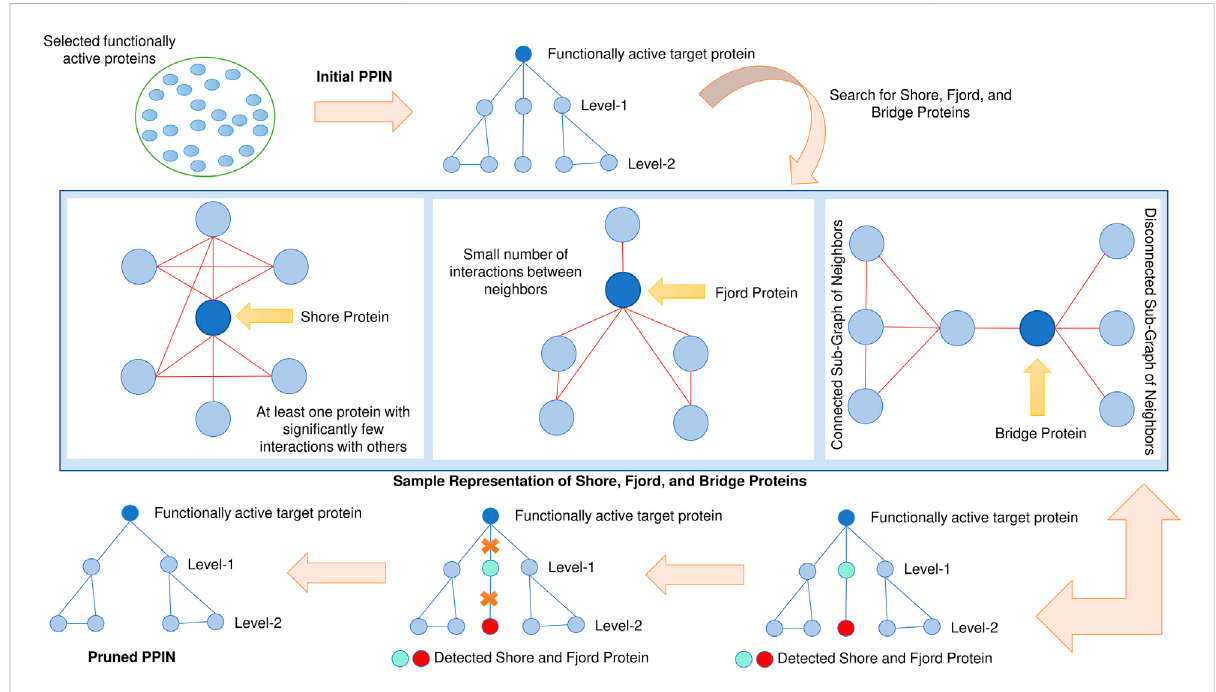
FIGURE 2 Pruning of target neighborhood graphs. Bridge, fjord, and shore proteins are detected and